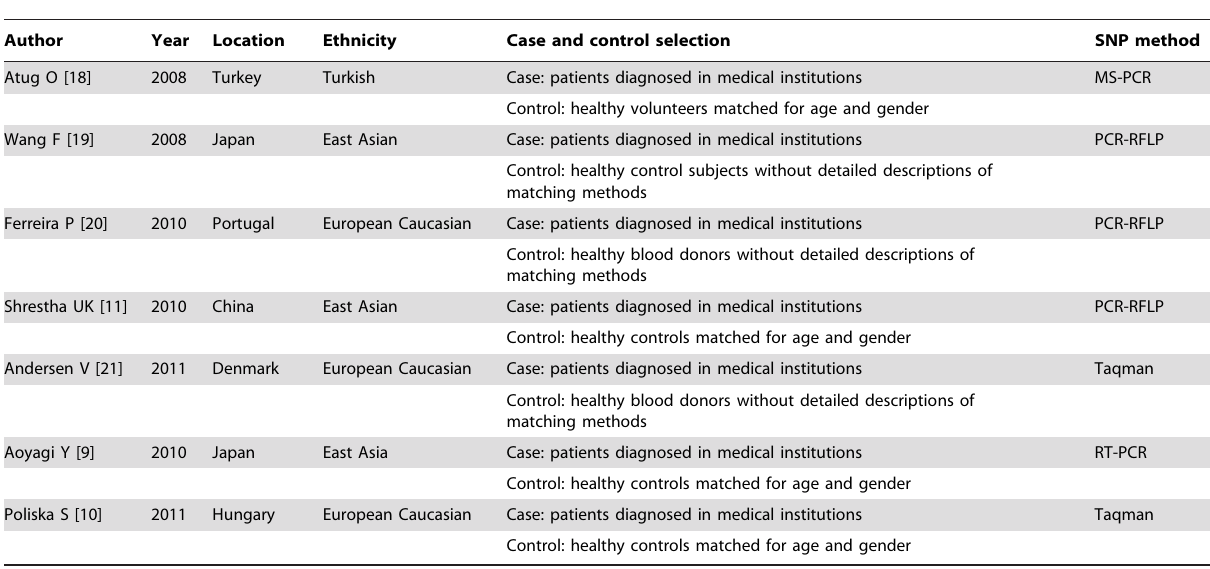
Table 1. Characteristics of included studies evaluating the association between the PPAR c Pro12Ala mutation and the presence of IBD.